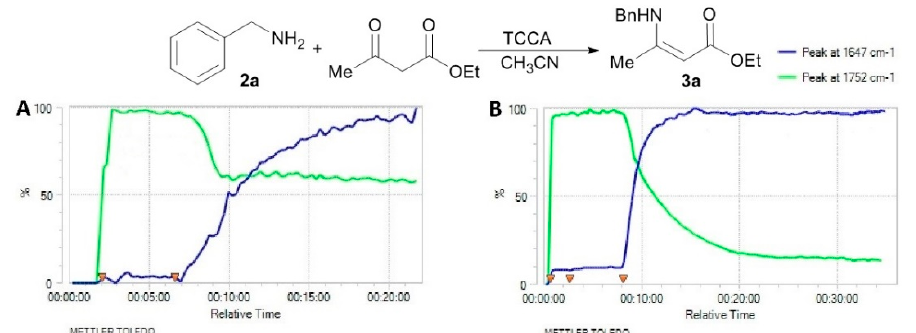
Figure 2. 2D trends of the React IR experiment. ( A ) Ethyl acetoacetate (1.0 g, 7.68 mmol), benzylamine (0.82 g, 7.68 mmol) and MeCN (5 mL) were used; ( B ) Ethyl acetoacetate (1.0 g, 7.68 mmol), benzylamine (0.82 g, 7.68 mmol), TCCA (34.8 mg, 0.15 mmol) and MeCN (5 mL) were used. The reaction